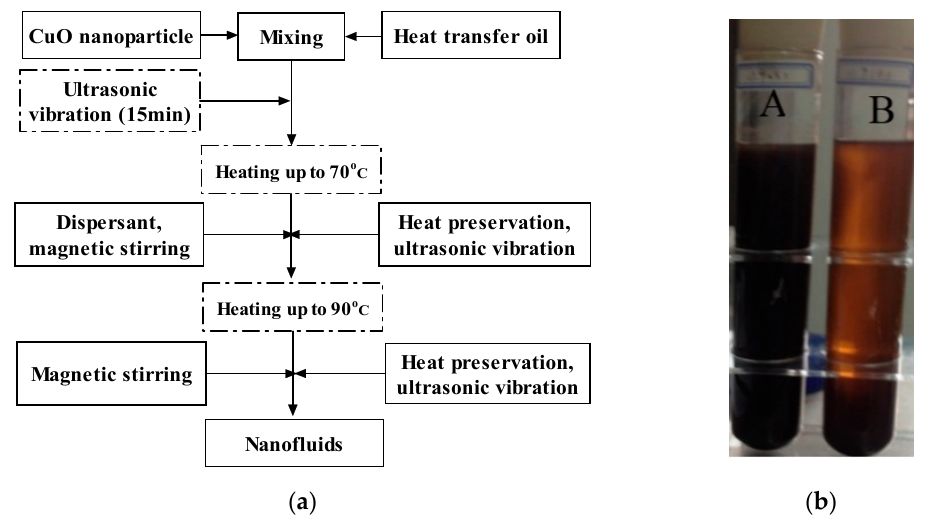
Figure 3. Nanofluids-preparing process. ( a ) The “two-step” method (additional steps are shown by dotted boxes). ( b ) Prepared nanofluids after a 3-day settling test at room temperature. A in ( b ) represents the modified two-step method, and (B) in ( b ) represents a conventional two-step method discussed in the literature [36].